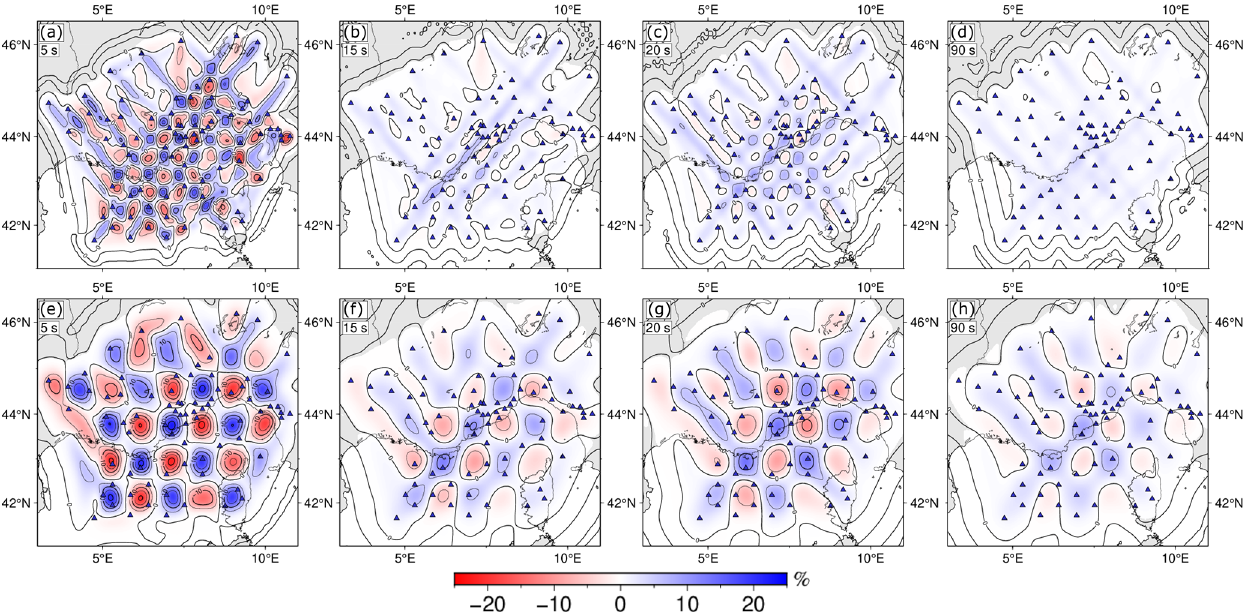
Figure 7. Checkerboard tests for periods of 5, 15 (both ambient noise cross-correlation), 20, and 90s (both teleseismic cross-correlation). The perturbation of the input checkerboard tiles is set to ± 25%. Panels (a) – (d) show checkerboard tests with a grid size of 0.4 ◦ × 0.4 ◦ ; panels (e) – (h) show a grid size of 0.8 ◦ × 0.8 ◦ . The standard deviation of Gaussian noise (of travel times) is set to 0.375s for (a) and (e) , 0.665s for (b) and (f) , 0.708s for (c) and (g) , and 1s for (d) and (h) . Checkerboard tests for all other periods can be found in the Supplement (Figs. S3–S6). Blue triangles represent